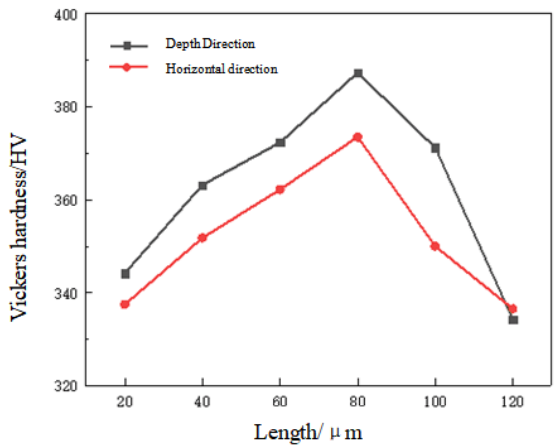
Figure 20. Hardness along the depth and horizontal direction.